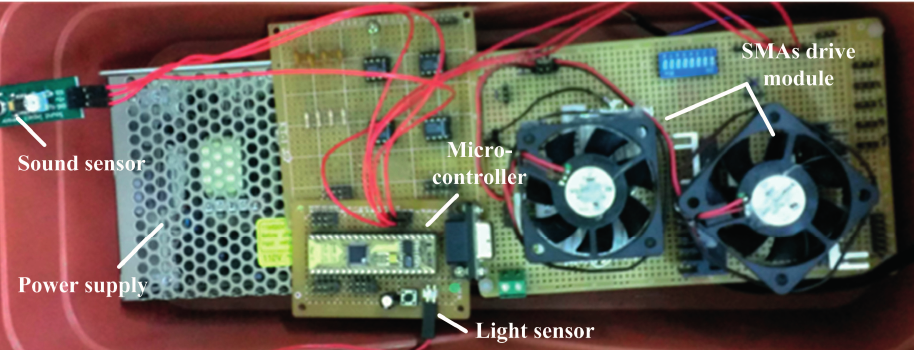
Figure 12. Embedded control